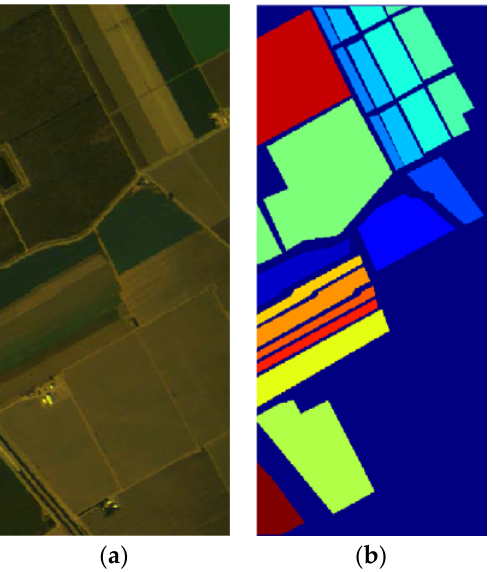
Figure 6. Salinas scene data set. ( a ) False-color image of the Salinas scene data. ( b ) Ground-truth map of the Salinas scene.